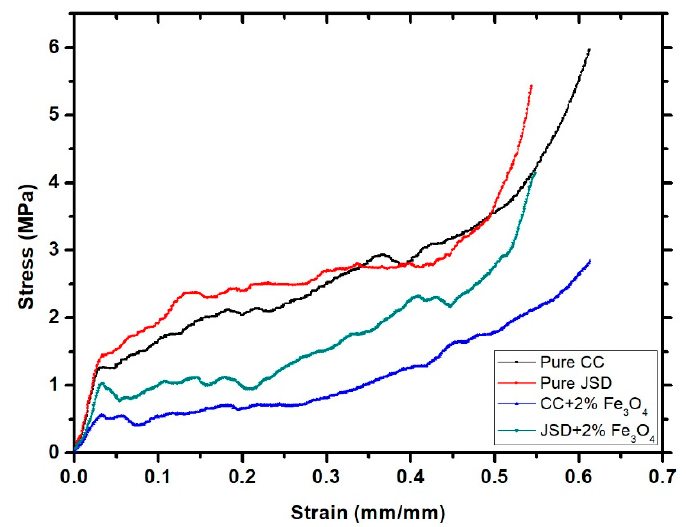
Figure 13. Stress–strain curves of the pure polymers and their composites.